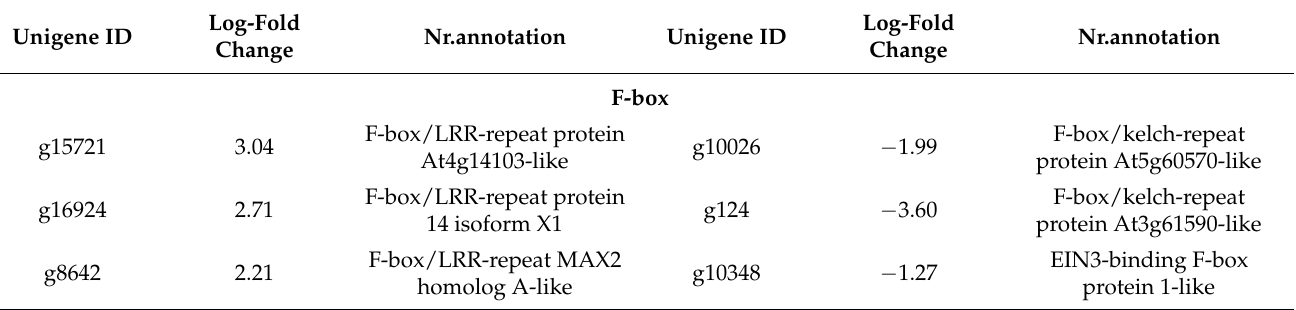
Table 3. Identified transcription factors in date palm leaf tissues under UV-B